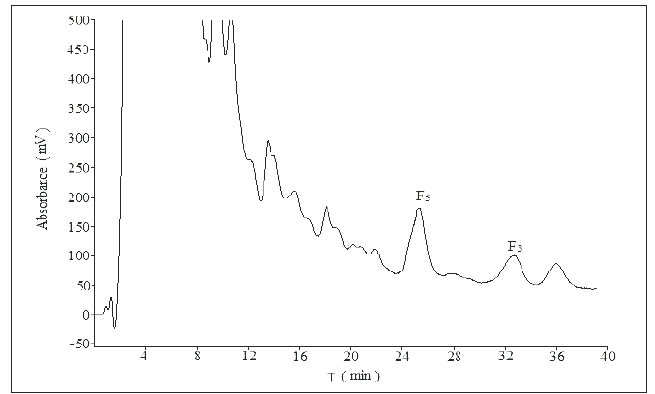
Figure 9. The semi-preparative chromatogram of CEFBPG with the mobile phase of acetonitrile:water 32:68 → 28:72 (10 min) at room temperature and a flow rate of 10 mL/min. Table 1. The influence of the volume ratios of mobile phase on the separation effect of crude extracts of flower buds of P. ginseng